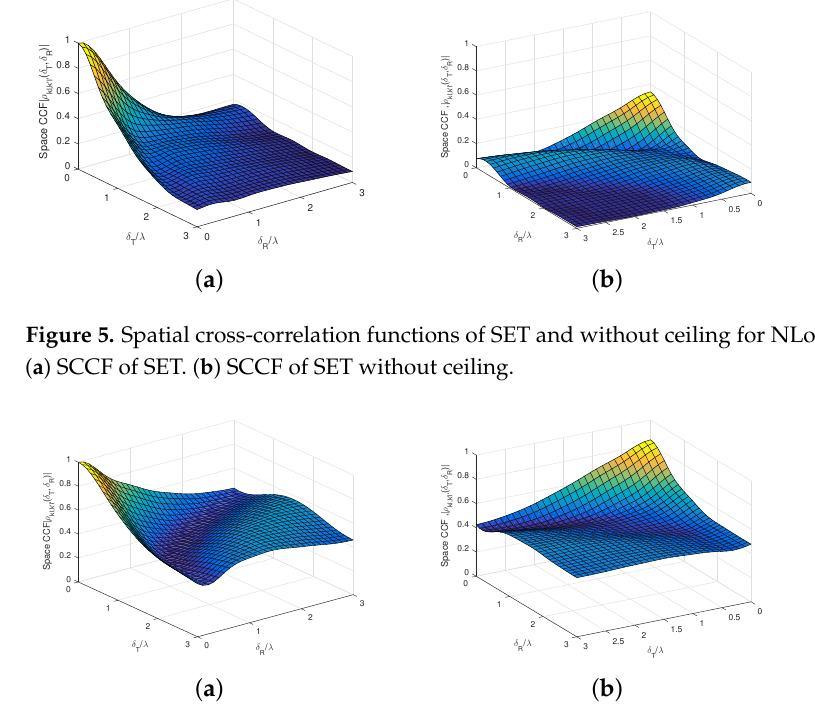
Figure 6. Spatial cross-correlation functions of SET and without ceiling for LoS scenario ( c R = 1 ) . ( a ) SCCF of SET. ( b ) SCCF of SET without